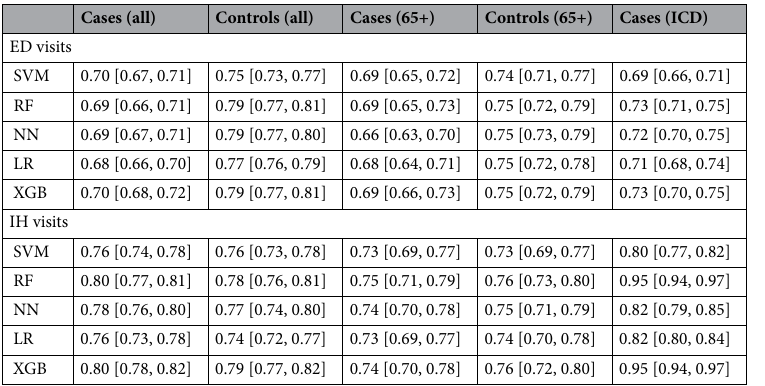
Table 5. Intra-cohort evaluation: AUC and 95% confidence interval of test samples for models trained on sociodemographic variables (So) and Elixhauser comorbidity conditions (Dx).